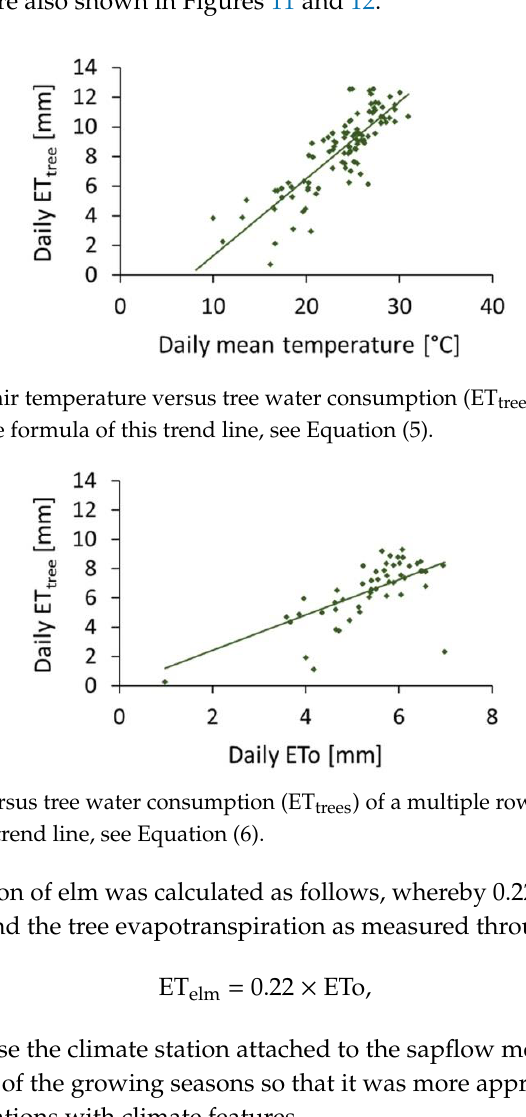
Table 5. ETo [mm] of open field conditions and under impact of different wind break types and grid sizes. Tree Wind Break